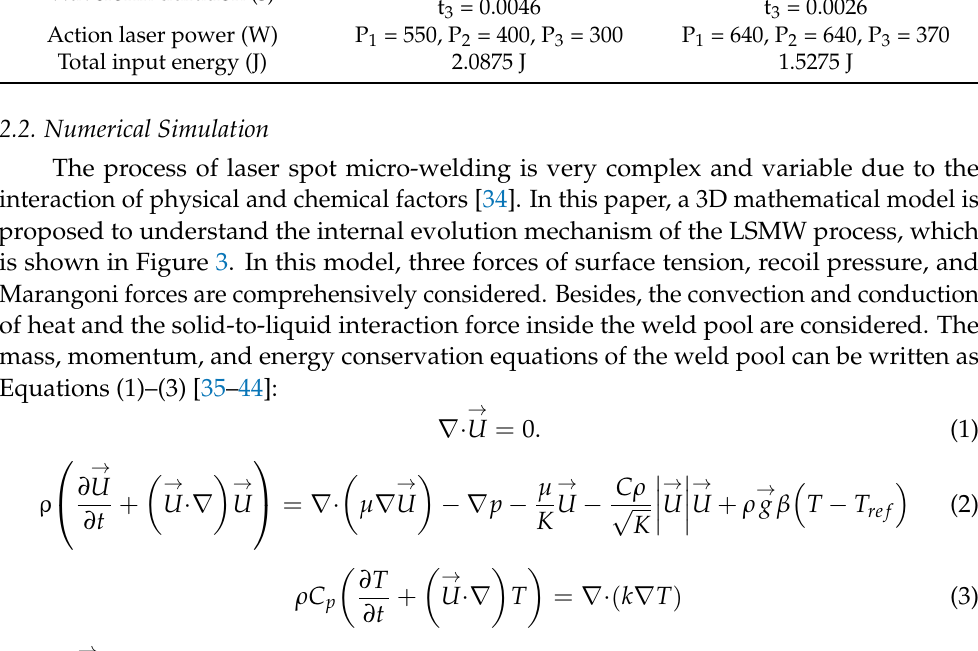
Table 2. Experimental process parameters of LSMW on the ANSI 304 stainless steel sheet.